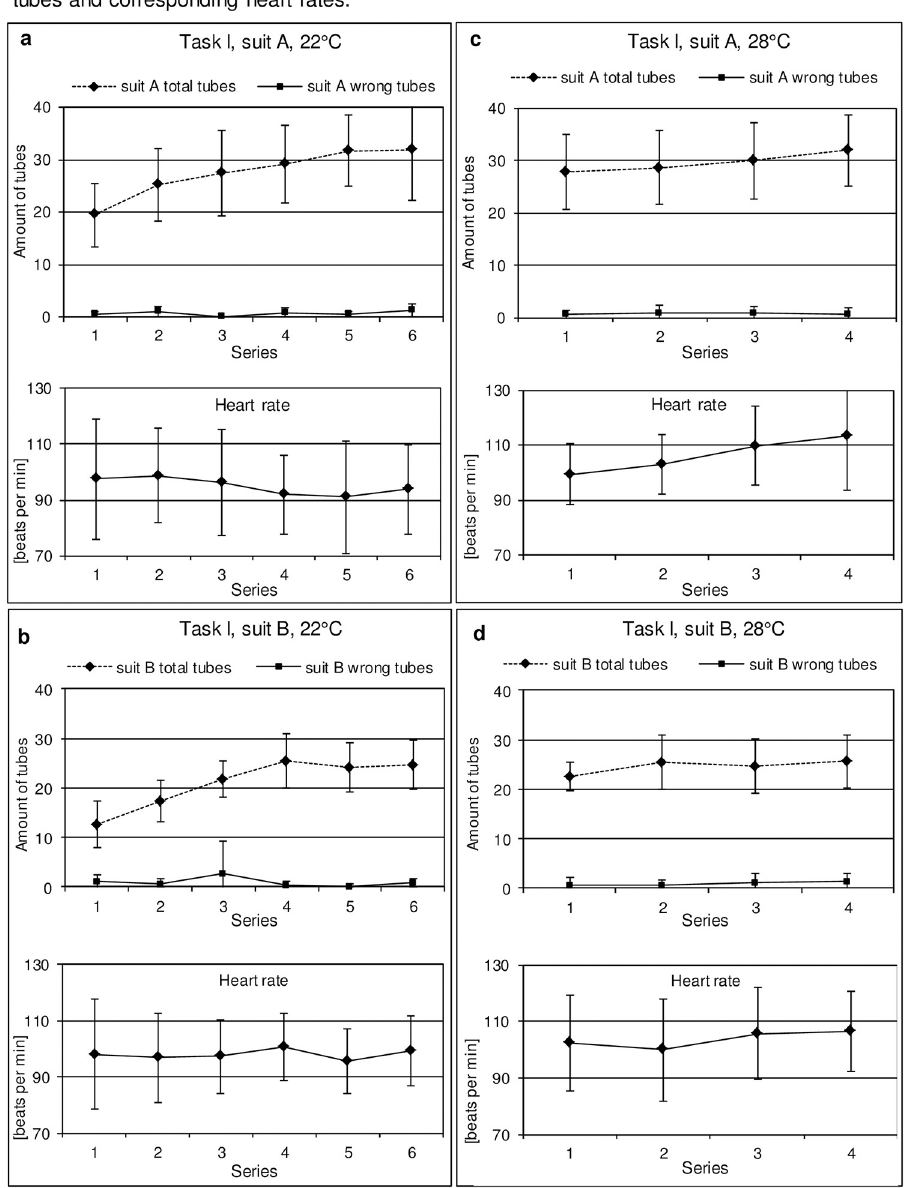
Fig 3. Results of task I (screwing tubes). Graphs show mean values and standard deviations calculated from the amount of all processed and wrongly screwed tubes (Y-axis) for 6 series (X-axis) by the subjects under the indicated conditions. (a) Suit A at 22˚C, 6 series. (b) Suit B at 22˚C, 6 series. (c) Suit A at 28˚C, 4 series. (d) Suit B, 28˚C, 4 series. The corresponding heart rates during the various task series are shown in the corresponding panels